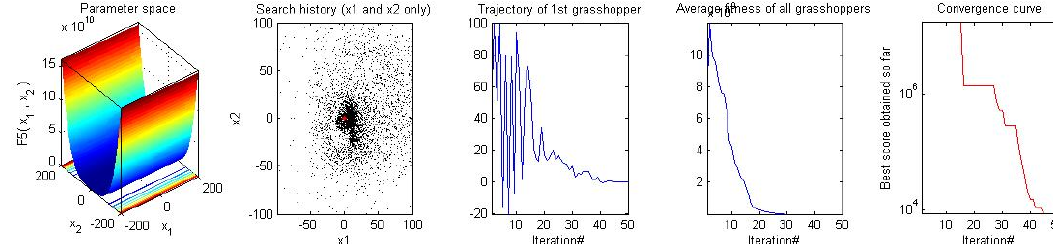
Figure 6. HAGOA search behavior on unimodal function (F5)